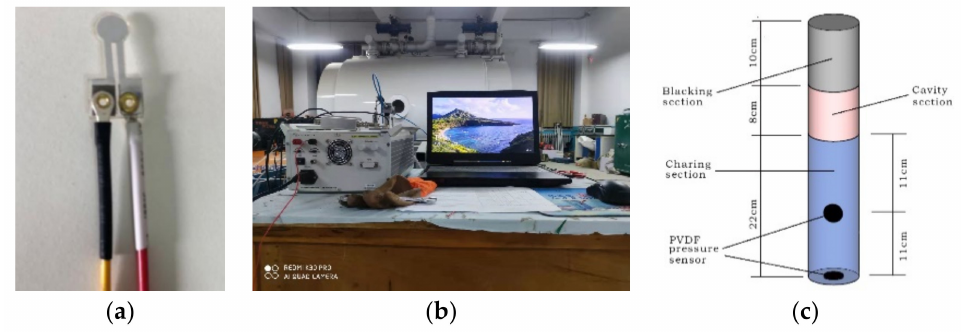
Figure 2. Borehole wall pressure test: ( a ) PVDF piezoelectric sensors: ( b ) DH5922N Dynamic Strain Gauge: ( c ) Borehole wall pressure test